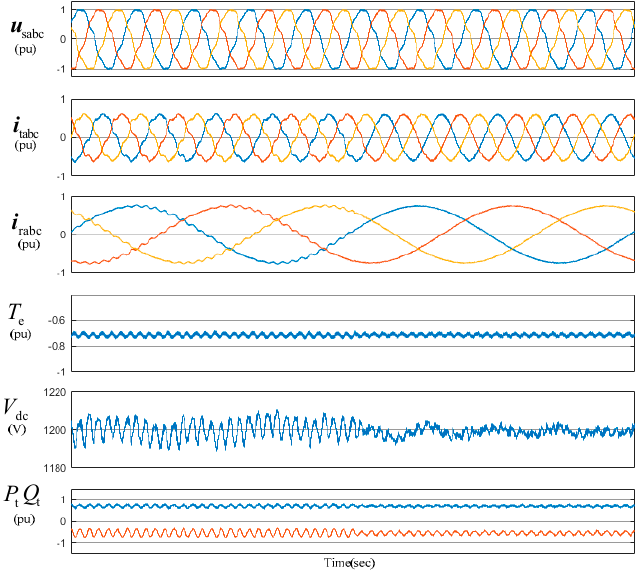
Table 2. Fast Fourier transform (FFT) of currents in Figure 8. ISMC: integral sliding mode control; MRSMC: multi-resonant-based sliding mode control.